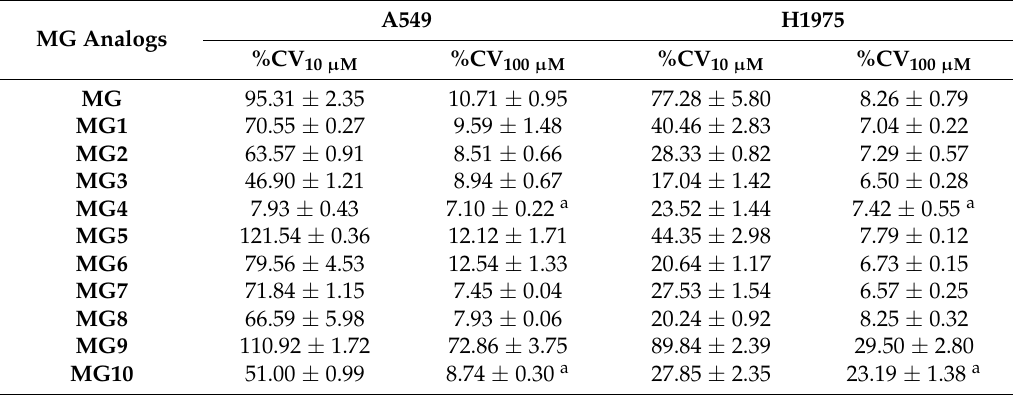
Table 1. In vitro cytotoxicity screening of all MG analogs against A549 and H1975 NSCLC cell lines. Cells were treated with indicated compounds at 10 µ M and 100 µ M for 48 h, and cell viability was determined using MTT assay. Data are expressed as mean ± SEM of two independent experiments. potent